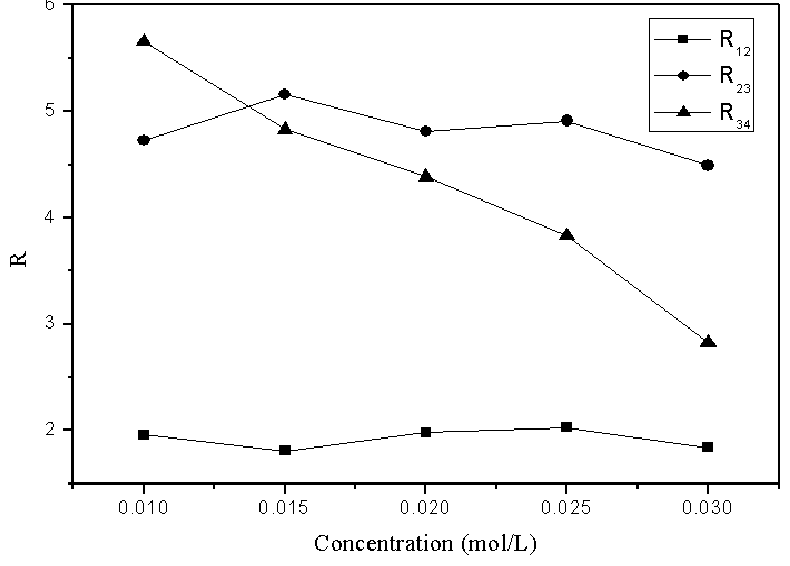
Figure 3 . Effect of the concentration of acetic acid on the resolution of the four compounds. (Error bars smaller than the symbols are not shown). 1: chlorogenic acid, 2: = resolution of chlorogenic acid and caffeic acid; caffeic acid, 3: scoparone, 4: rutin; R 12 = resolution of caffeic acid and scoparone; R = resolution of scoparone and R 23 34